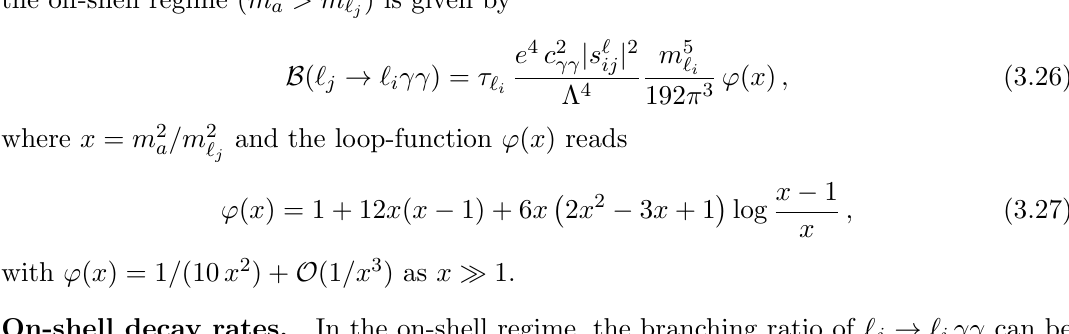
Figure 3 . Dominant contribution to ‘ j O(cid:11)-shell decay